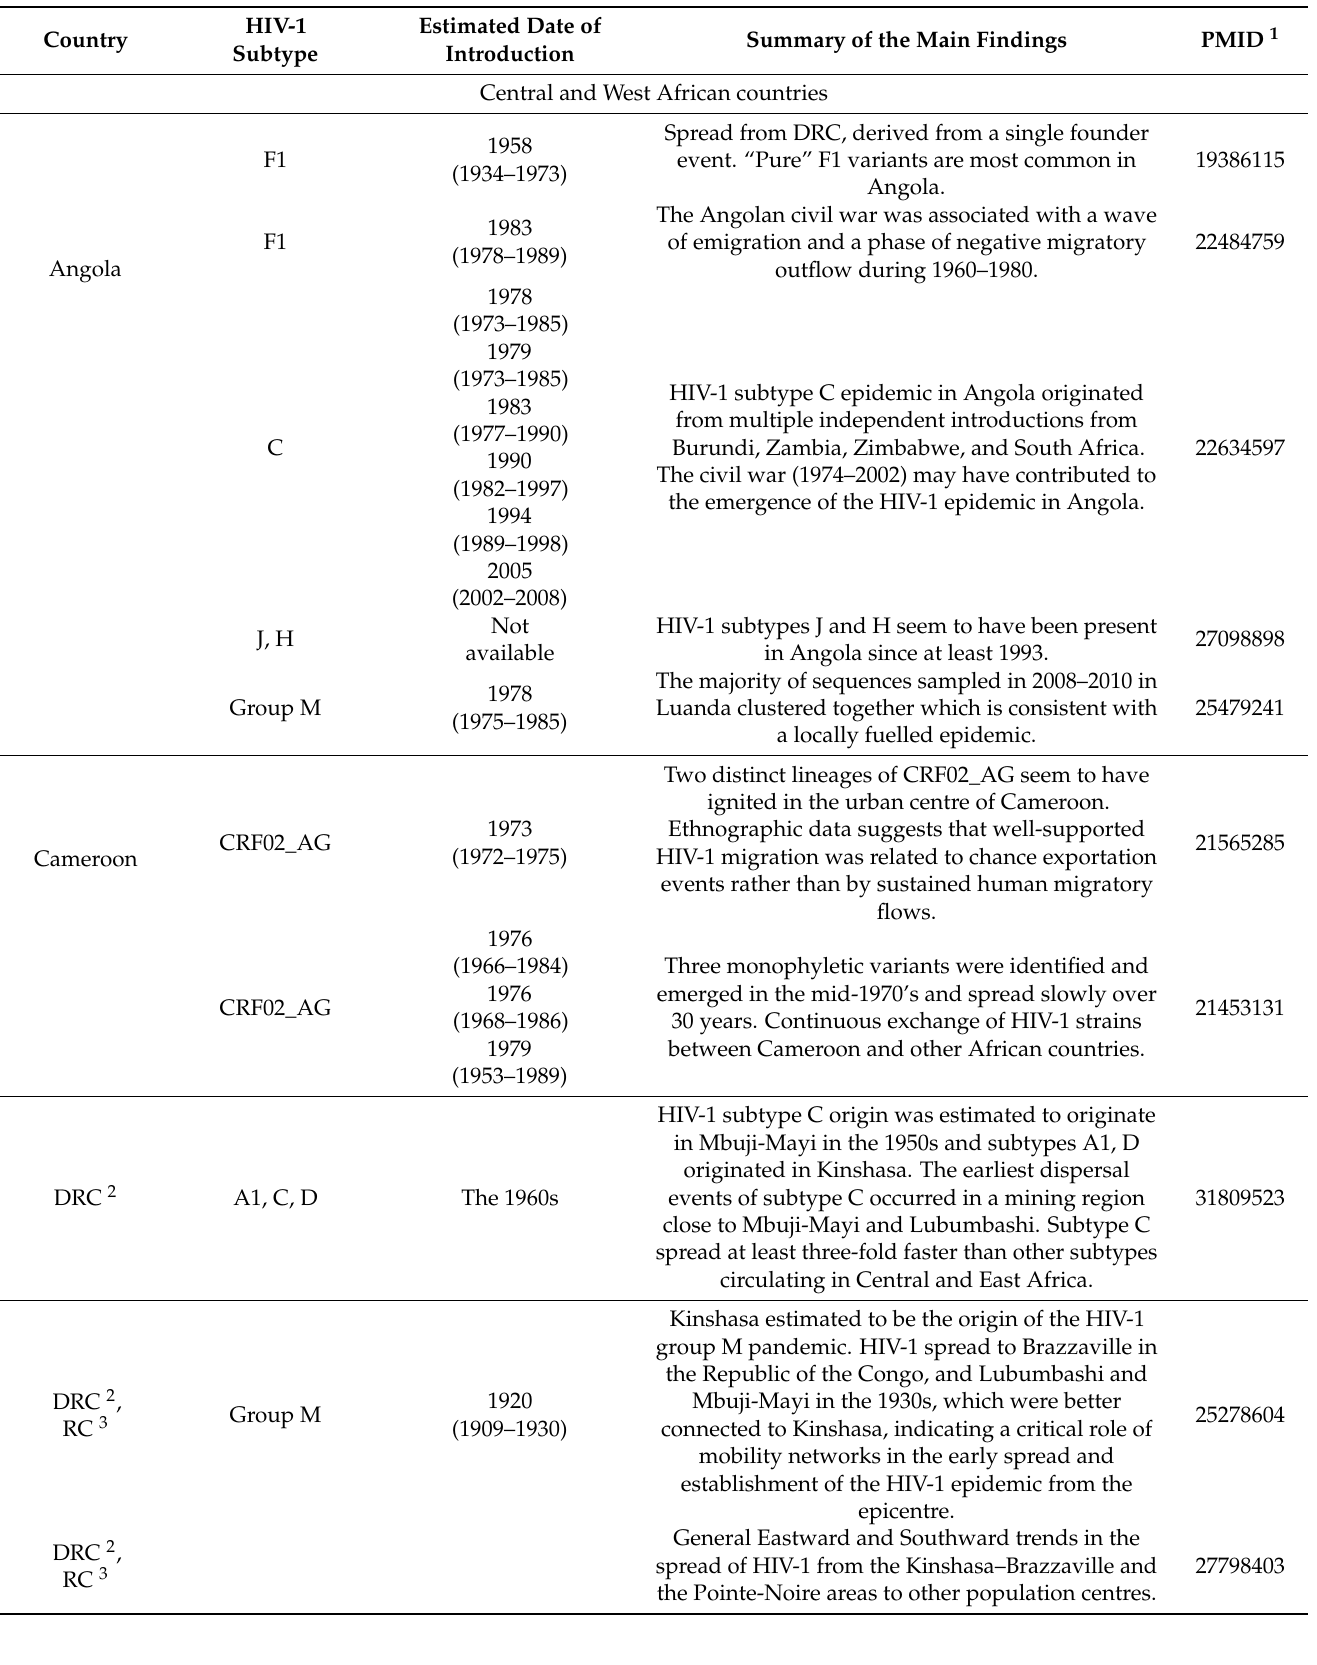
Table 1. Summary of HIV-1 phylogenetic studies in sSA from geographical